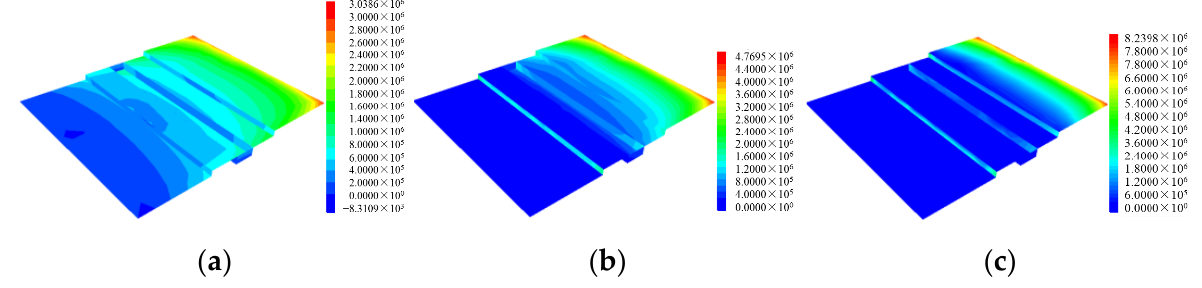
Figure 16. Variation of the displacement of the foundation rock mass with the increasing lateral thrust. (Unit in m). ( a ) 2 × design load (500 kN); ( b ) 3 × design load (750 kN); ( c ) 4 × design load (1000 kN).